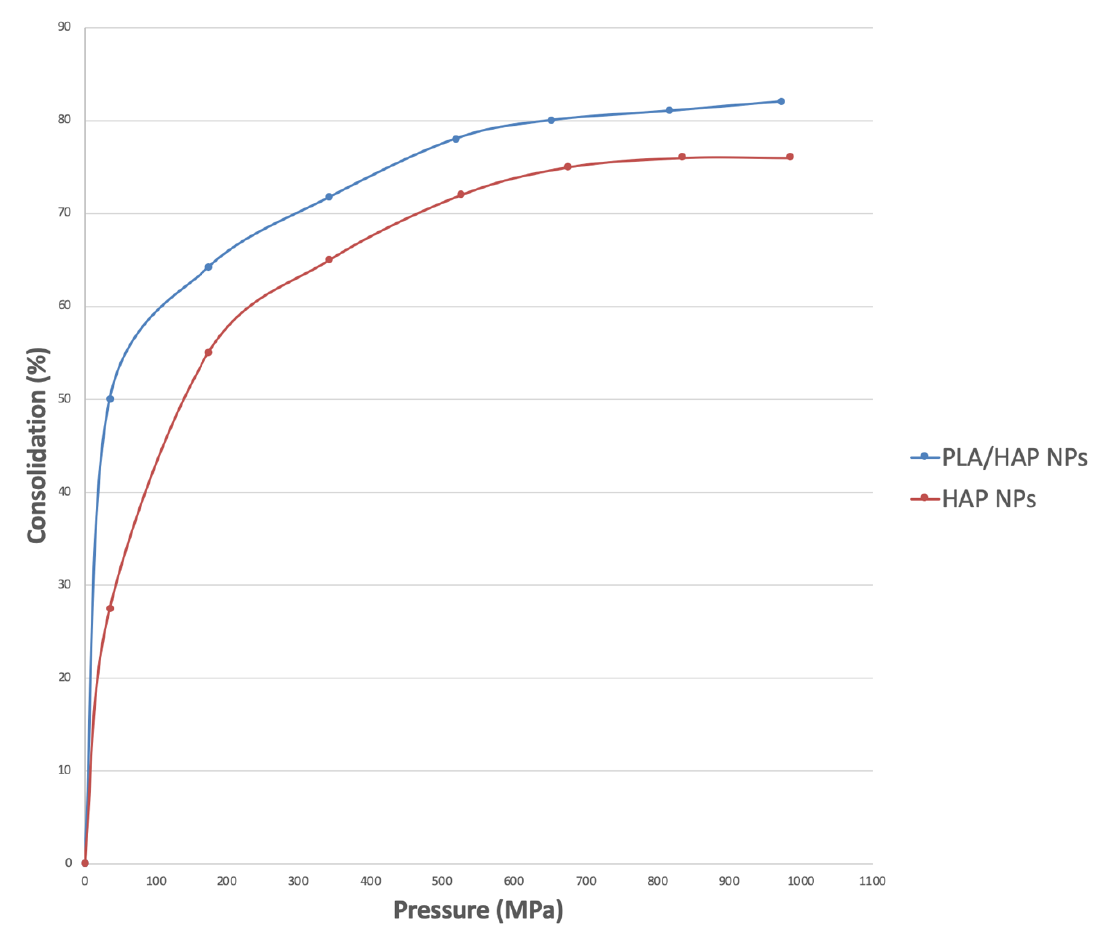
Figure 4. Densification of HAP NPs and composite granules (80 wt% of HAP NPs, 20 wt% of PLA) achieved during the uniaxial cold pressing.